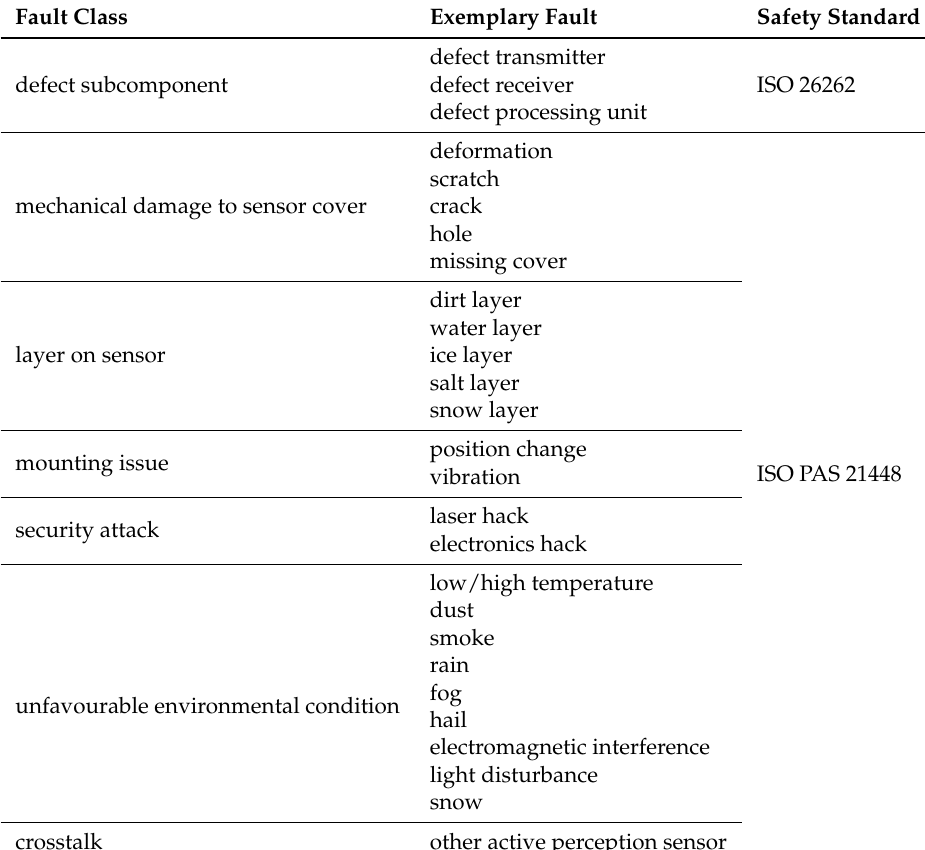
Figure 2. Schematic illustration of sensor fault classes. Table 1. Classification of perception sensor faults including exemplary faults and related international safety